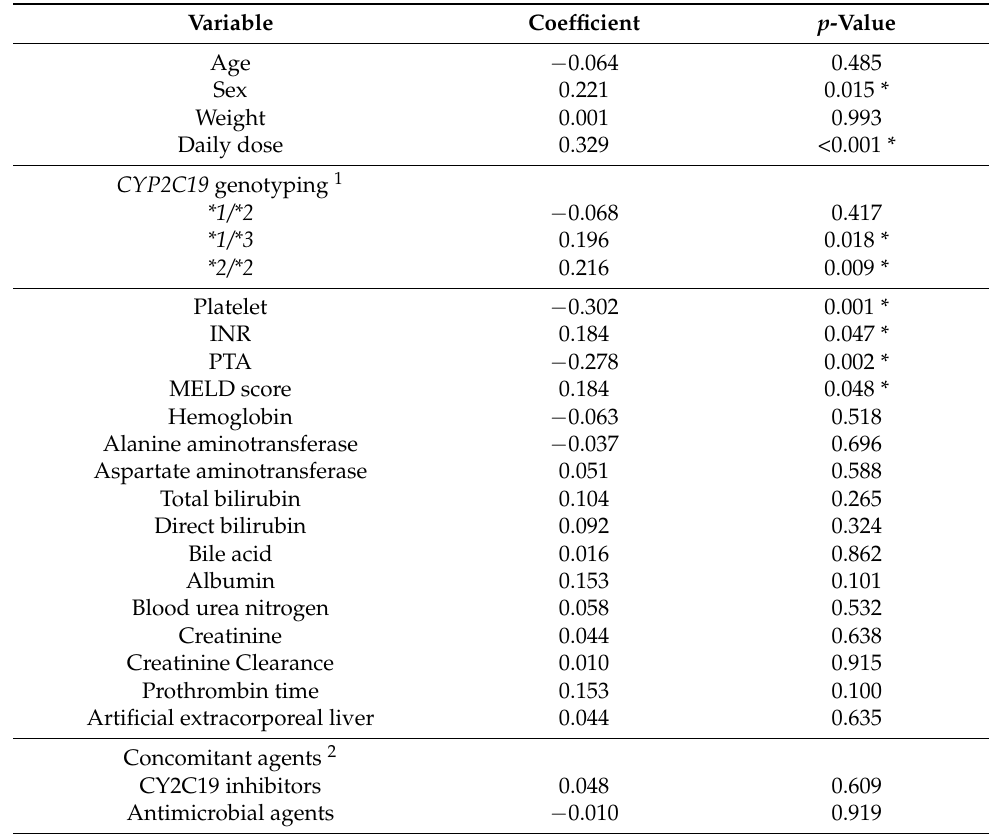
Table 3. Multivariate bivariate correlation analysis of factors associated with voriconazole plasma